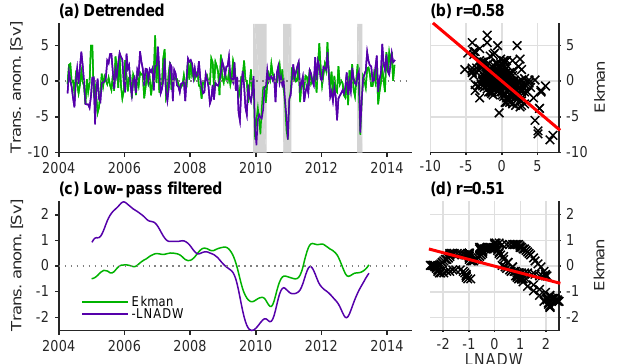
Figure 7. 10-day filtered transport anomaly time series of UMO and FC (a, b) and LNADW and Ekman (c, d) . The 10-year mean has been removed, but the seasonal cycle and trends are retained. Time ranges have been chosen to correspond to large anomalies in both time series, to visualize possible lags. (e) Lag correlation between 10-day filtered UMO and FC (magenta), and Ekman and LNADW (green); 95% significance is marked by the dashed lines, same